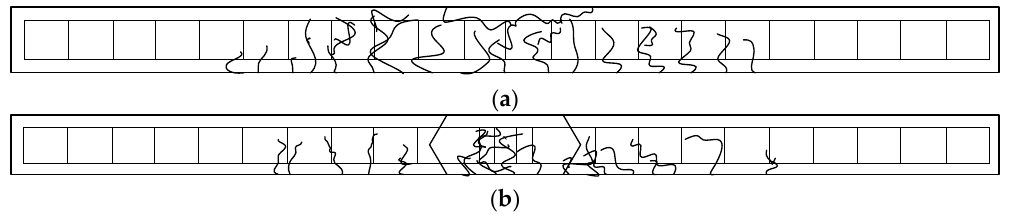
Figure 4. Result of crack progression: ( a ) cracking in the integral specimen; ( b ) cracking in the modular specimen.